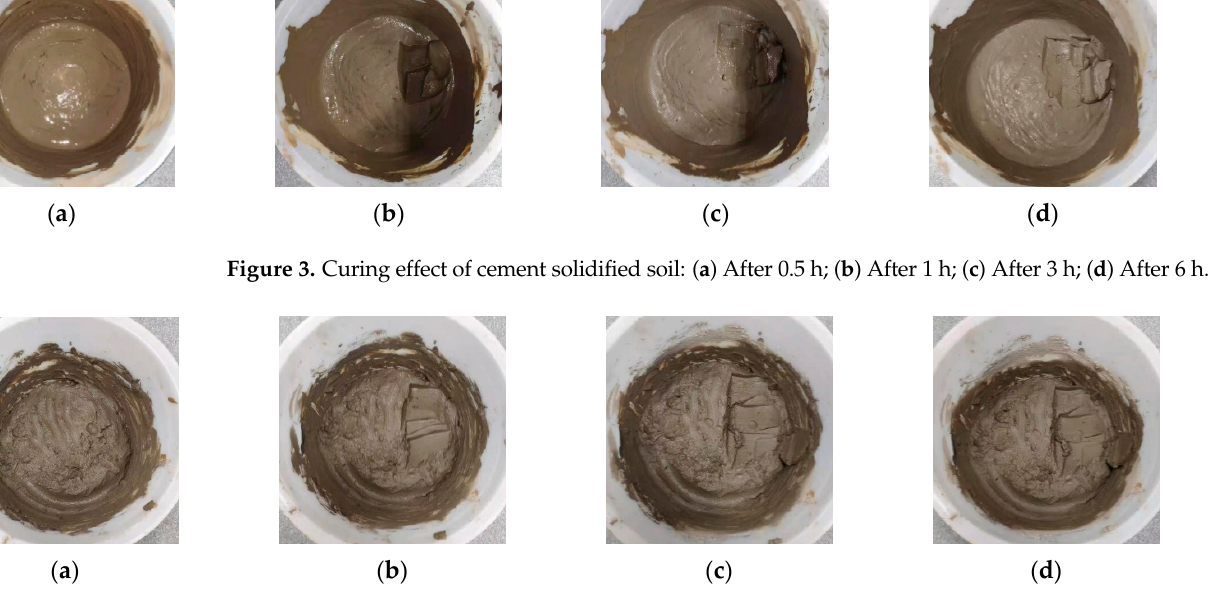
Figure 4. Curing effect of RCSLP solidified soil: ( a ) After 0.5 h; ( b ) After 1 h; ( c ) After 3 h; ( d ) After 6 h.